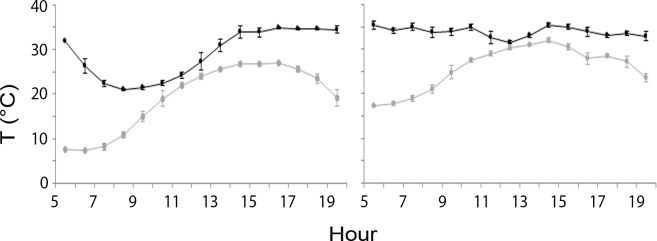
Daytime skin temperature patterns respectively representative of an upstream (left) and a downstream male (right) Myotis daubentonii simultaneously recorded in August 2012 at the Abruzzo Lazio and Molise National Park and its buffer zone (Central Italy).Skin temperature is given by the black line and ambient temperature by the grey line. When upstream males entered the roost, a body temperature drop was typically observed, leading to heterothermy, while downstream males remained mostly homeothermic in daytime.